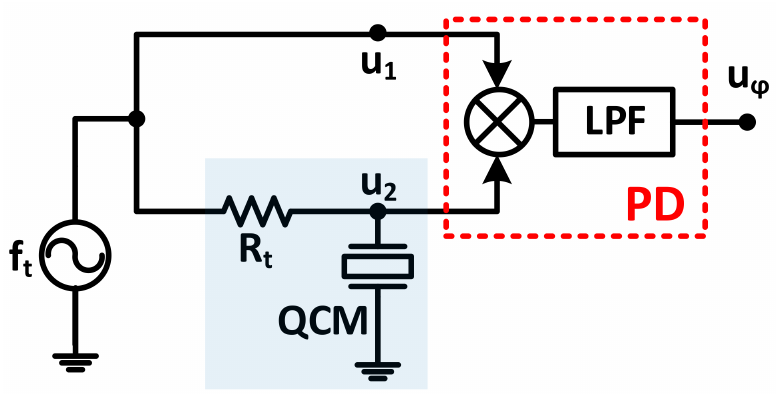
Figure 23. Phase-mass characterization generic block diagram from